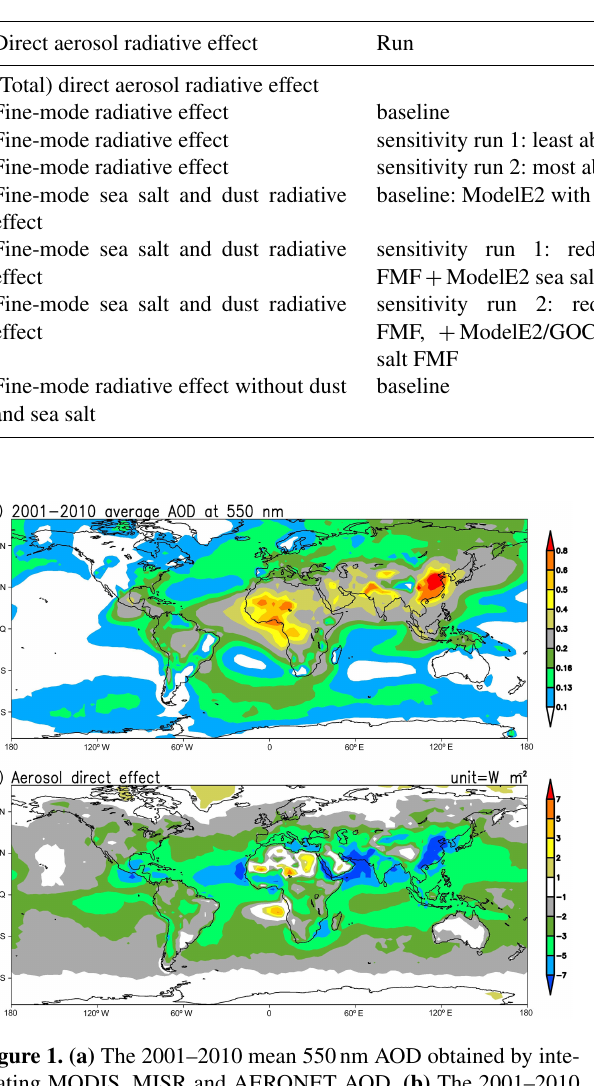
Table 1. Global 2001–2010 average of aerosol radiative effect calculated with the Monte-Carlo Aerosol Cloud Radiation (MACR) model. In this table, natural aerosol radiative effects are included. All the aerosol radiative effect estimates made by the MACR model in this study include 3-D cloud effects.